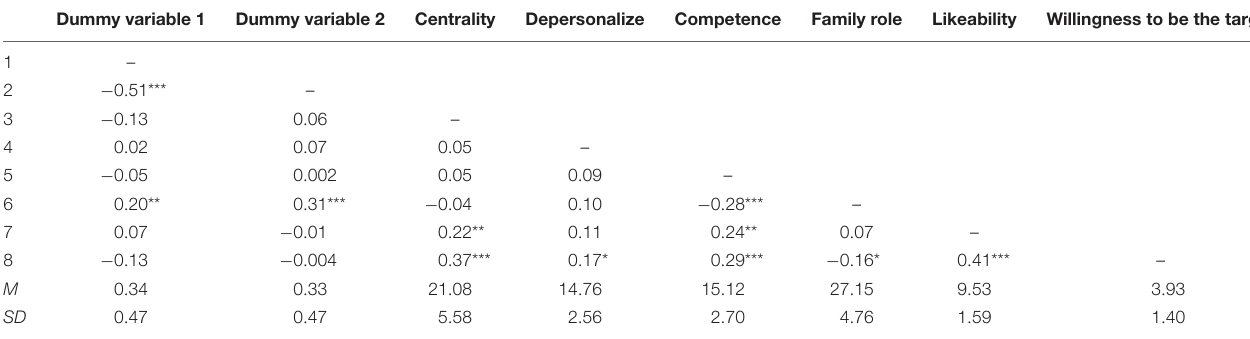
TABLE 1 | Correlations, means, and standard deviations for all variables in Experiment 1. Dummy variable 1